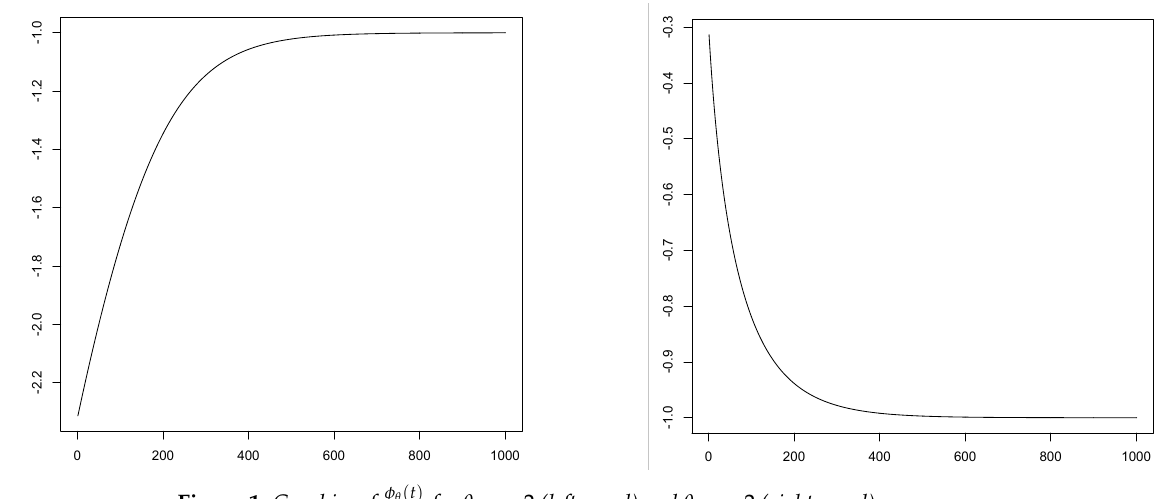
for θ = − 2 (left panel) and θ = − 2 (right Figure 1. Graphics of φ θ ( t ) φ (cid:48) θ ( t )